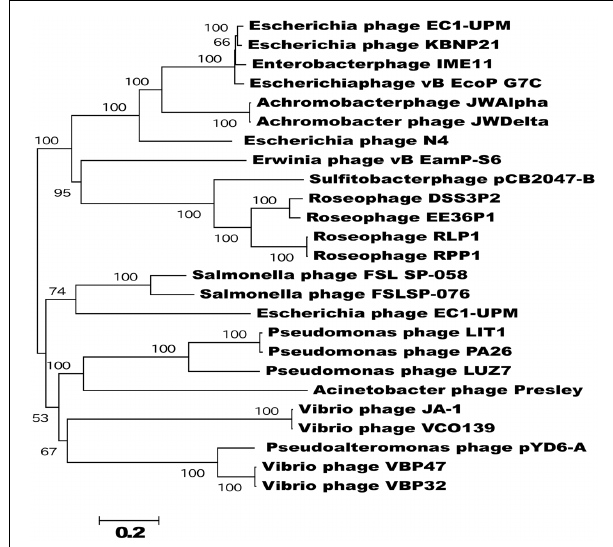
FIGURE 5 | Phylogram of concatenated core genes of the 25 sequenced N4-like phages. The neighbor-joining tree was based on a ClustalW alignment of the concatenated core genes amino acid sequences; bootstrap values were based on 1000 replicates. Apart from Escherichia phage EC1-UPM, N4-like phages that infect closely related hosts cluster together on well supported branches. The tree is rooted at mid-point and branches with less than 50% bootstrap replicates were collapsed; scale bar indicate expected changes per